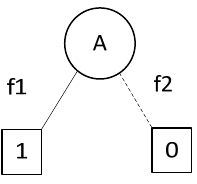
Figure 2. Binary Decision Diagram (BDD).